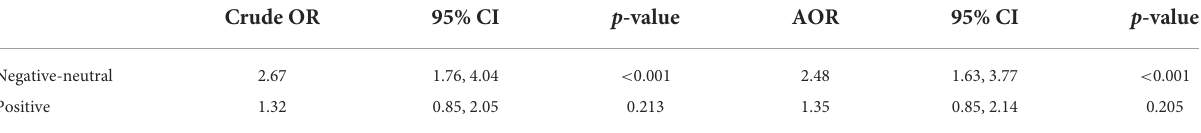
TABLE 5 Association between perceived behavioral control an intention stratified by total attitude